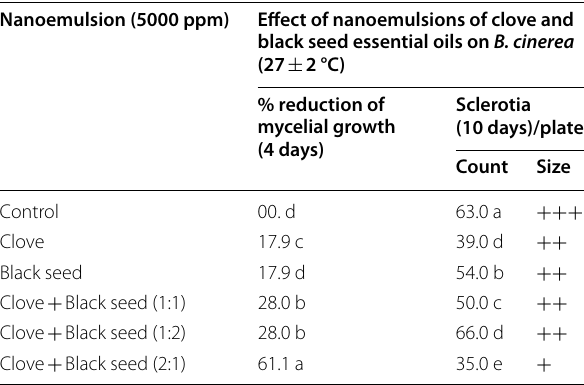
Table 3 Effect of nanoemulsions formulations of clove and black seed oils on mycelial growth and scleroial count of B. cinerea